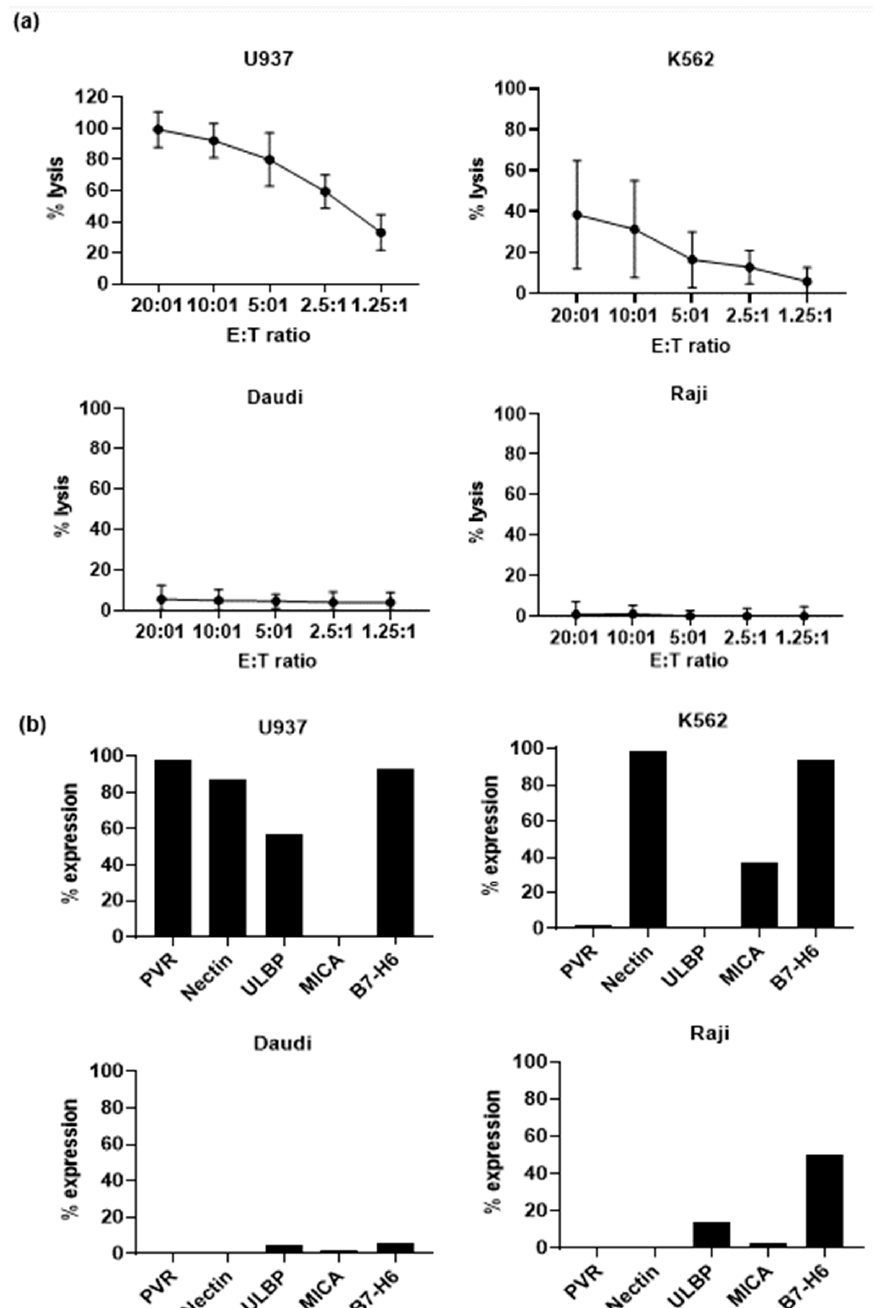
Figure 4. Expression of activating receptor ligands in target cells and V δ 1+ T-cell cytotoxicity. ( a ) Cytotoxic assays using cultured V δ 1+ T cells were performed against U937, K562, Daudi, and Raji cells in vitro ( n = 6). ( b ) Expression of activating receptor ligands on target cell lines analyzed by flow cytometry and various E:T ratios (from 20:1 to 1.25:1). γδ T cells were co-cultured with calcein AM-labeled target cells at the indicated E:T ratios for 4 h. The supernatants were harvested, and fluorescence analyzed with a microplate reader. The percentage of specific lysis was calculated as [(experimental emission − spontaneous emission) / (maximum emission − spontaneous emission)] × 100. Data shown in ( a ) are the mean ± SD of % lysis of indicated tumor by V δ 1+ T cells co-cultured in 3 technical replicates for the indicated E:T ratios and from 6 independent donors. After co-culturing V δ 1+ T cells and target cells at an E:T ratio of 2:1 for 24 h,